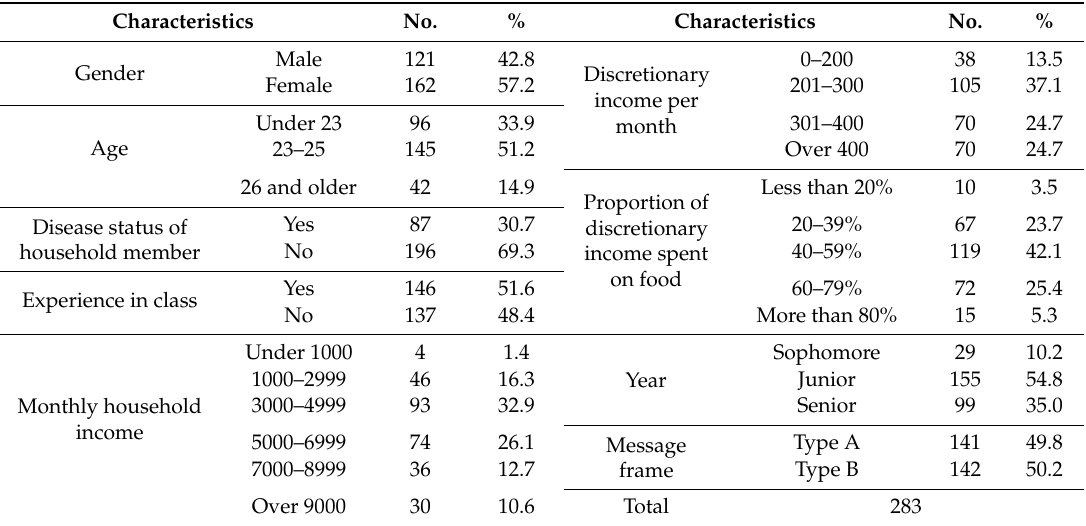
Table 2. Demographic characteristics of participants.